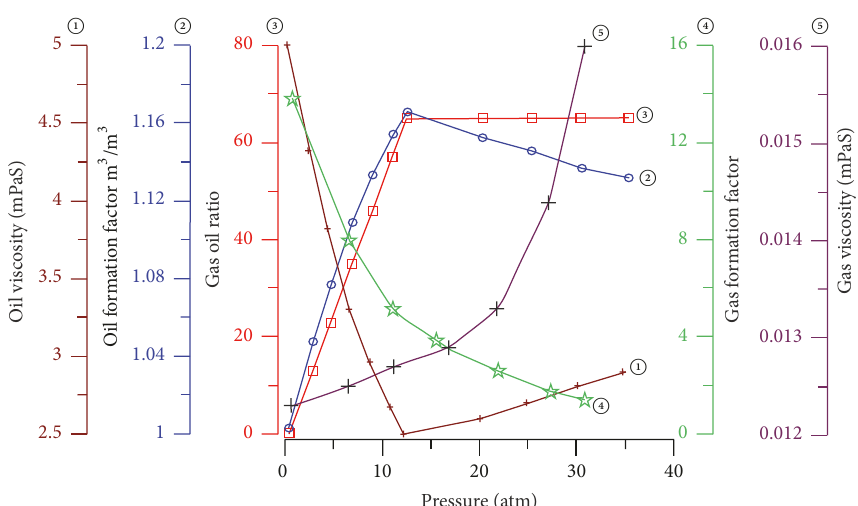
Figure 3: Reservoir block PVT data curve. Note . Curve A is the crude oil viscosity curve, curve B is the oil volume factor curve; curve C is solution gas-oil ratio curve; curve D is gas formation volume factor curve; curve E is gas viscosity curve.